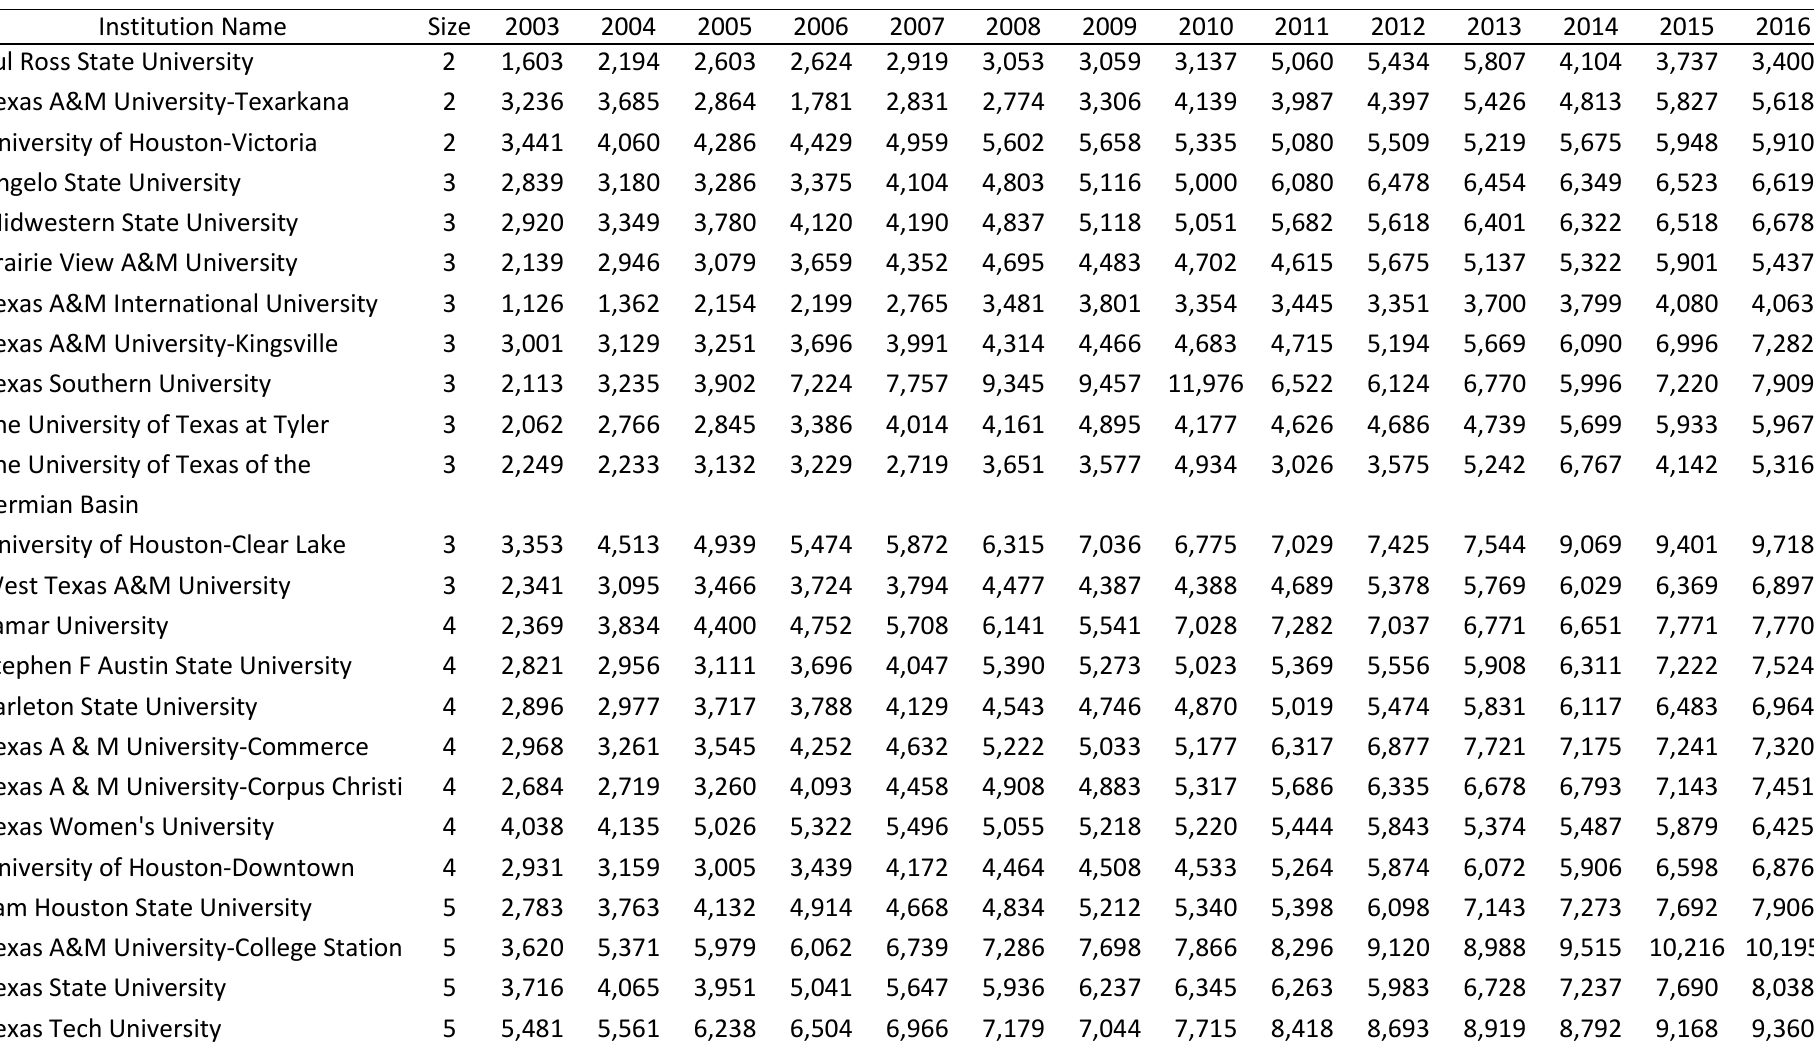
Table 5: Revenue from Tuition and Fees per FTE Student for FY 2003 to FY 2016 by Institutional